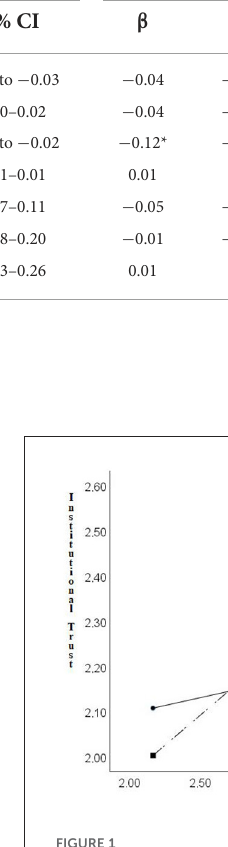
TABLE 5 Relation between perceived coronavirus threat and perceived closeness with the participants’ town/village and Russian population (as a whole) (simple linear regression with control of demographic variables, N = 500). Predictor and controls Participants’ town/village (Model 7)